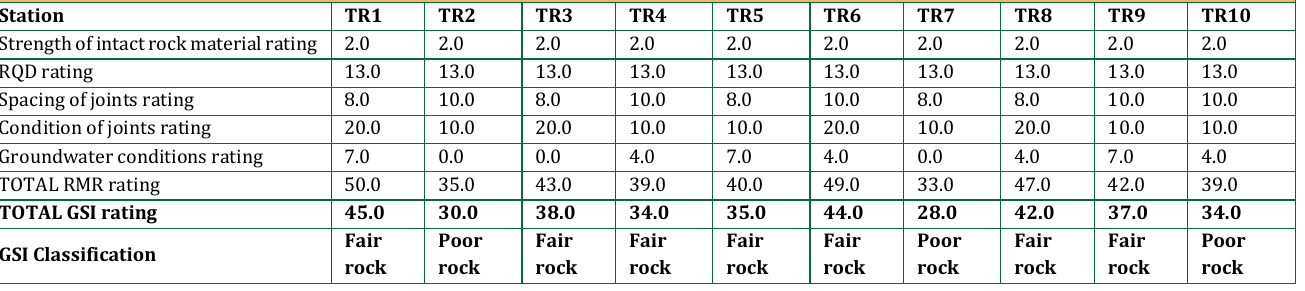
Table 3: The total summarizes rating for the Geological Strength Index (GSI) results